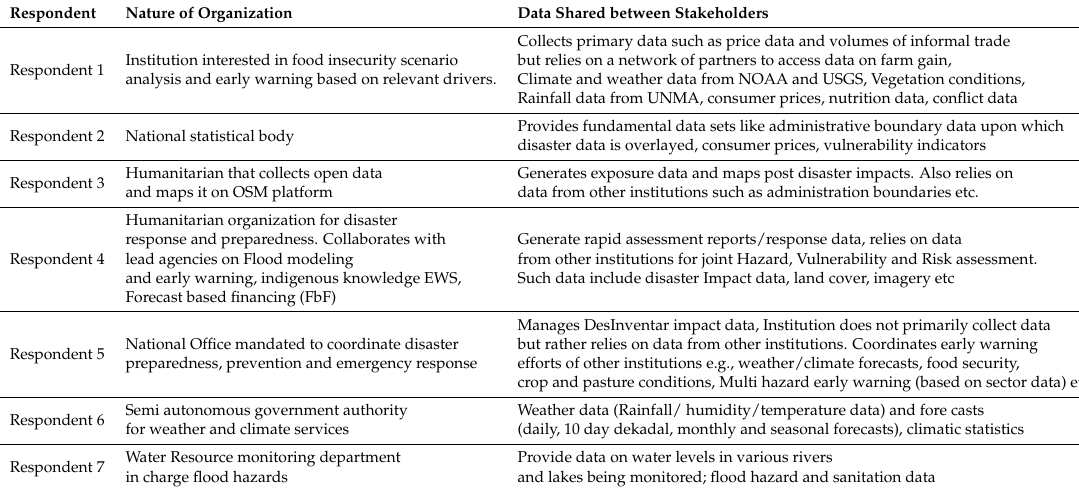
Table A3. Description of respondents in the